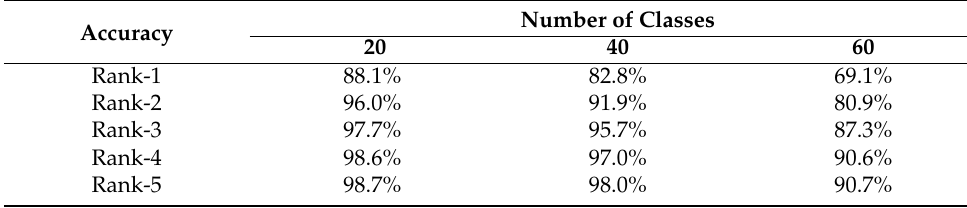
Table 8. The accuracy of prediction for 20, 40, and 60